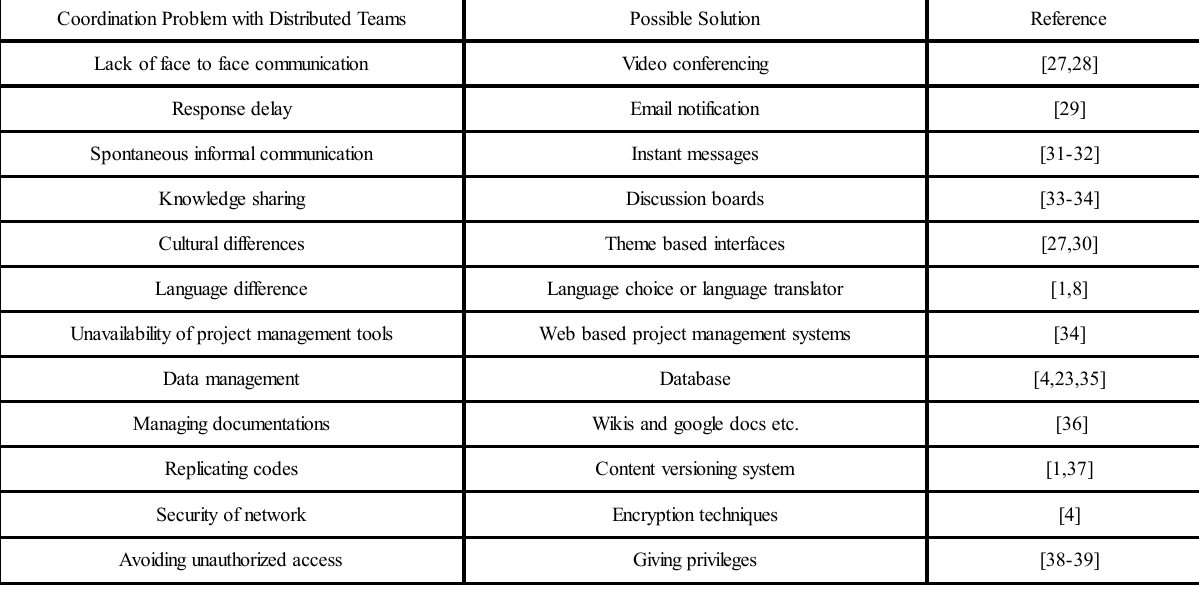
TABLE 1. COORDINATION PROBLEMS IN DISTRIBUTED ENVIORNMENT AND THEIR POSSIBLE